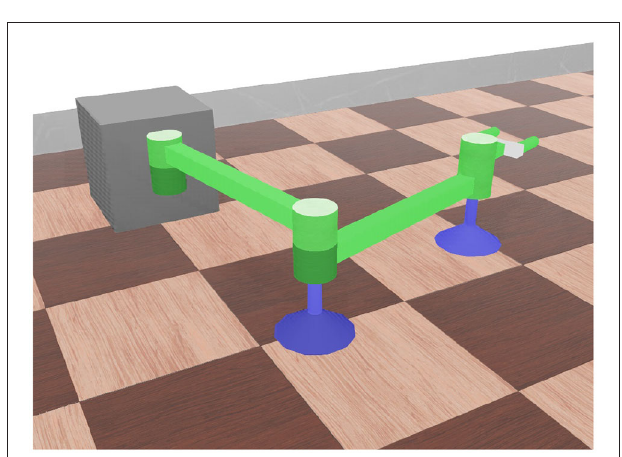
FIGURE 4 | Simulation model of an air bearing supported manipulator.